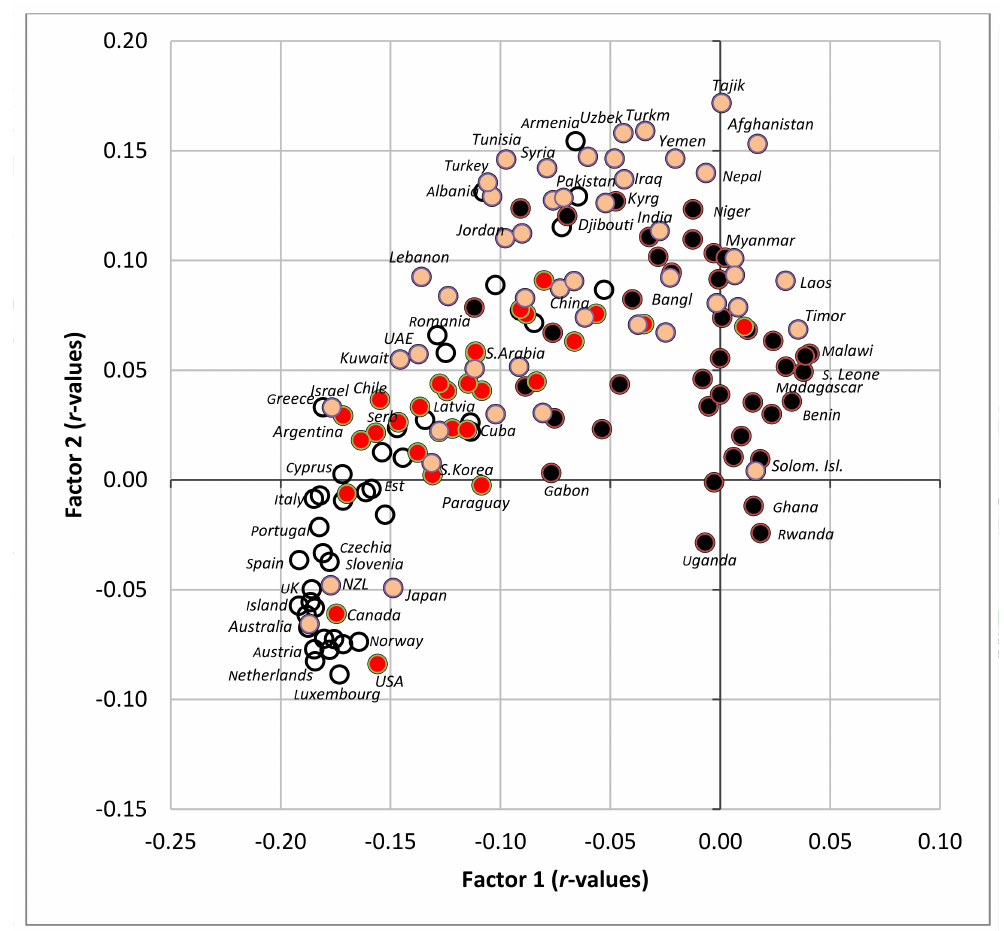
Figure 9. Projection of 158 countries on the factor plane of Figure